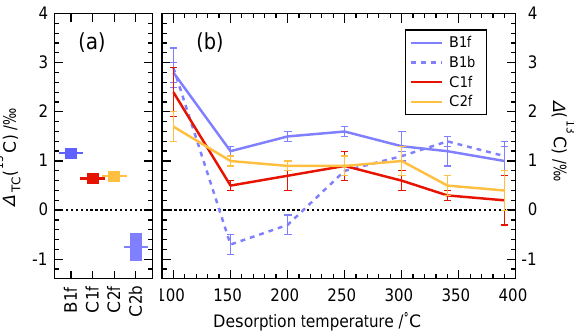
(cid:16) (cid:17) 13 C values of alpha-pinene SOA filter samples. Full Figure 6. (cid:49) lines represent front filters, and dashed lines back filters. Error bars denote 1- σ standard deviations and are propagated; they vary with loading. (a) TC analysis of selected filters (see x axis). (b) Thermal desorption analysis of filter material.